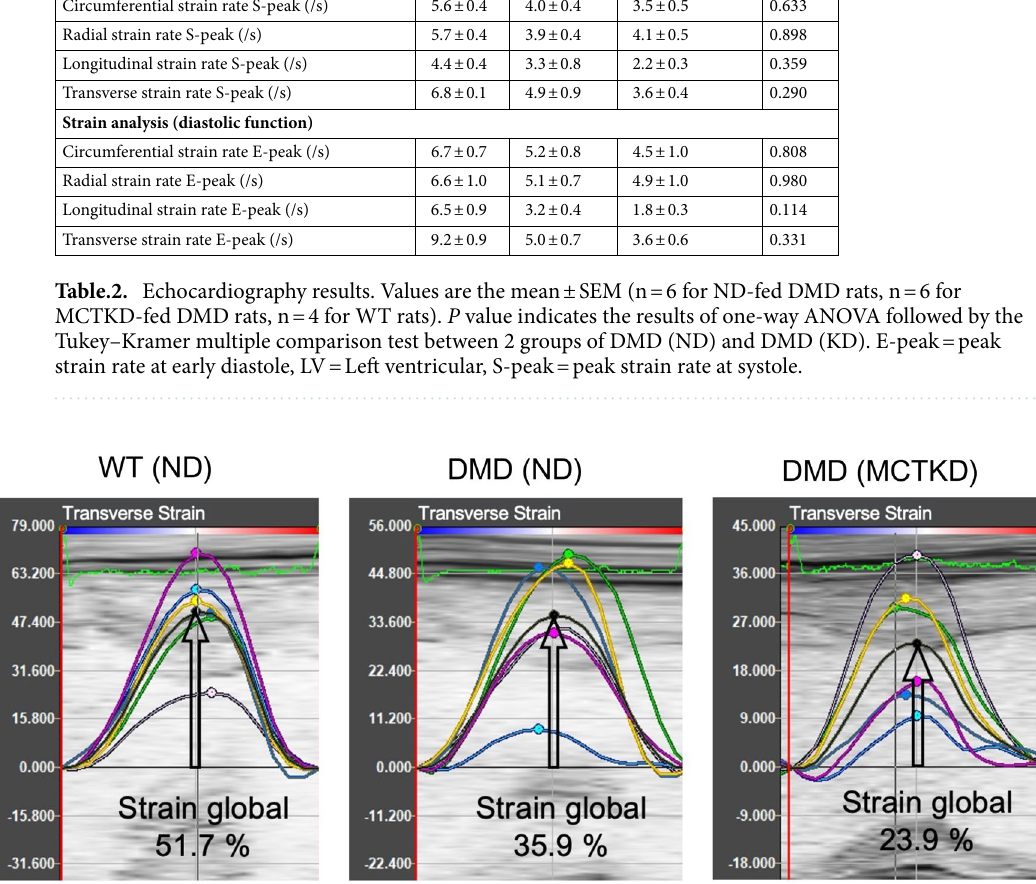
Figure 3. Representative images of speckle tracking strain analysis. A trend toward a decrease in transverse strain global was observed in MCTKD-fed DMD rats (arrows). The colored curves indicate the strain of each segment. The black curve indicates strain global of all